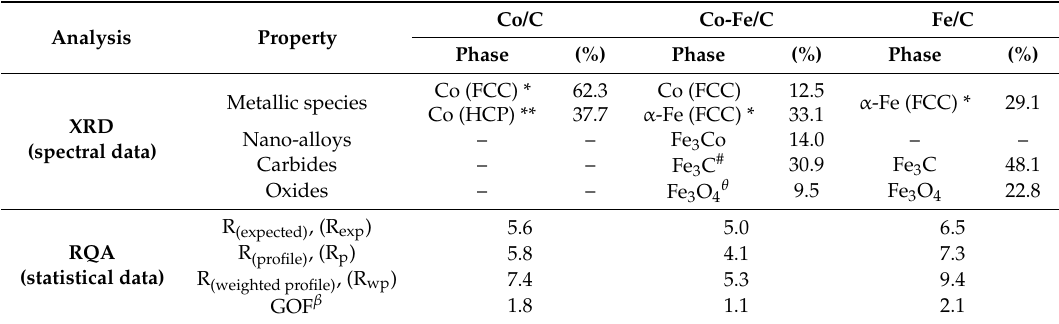
Table 4. Calculated phase composition of used catalyst samples by RQA from XRD